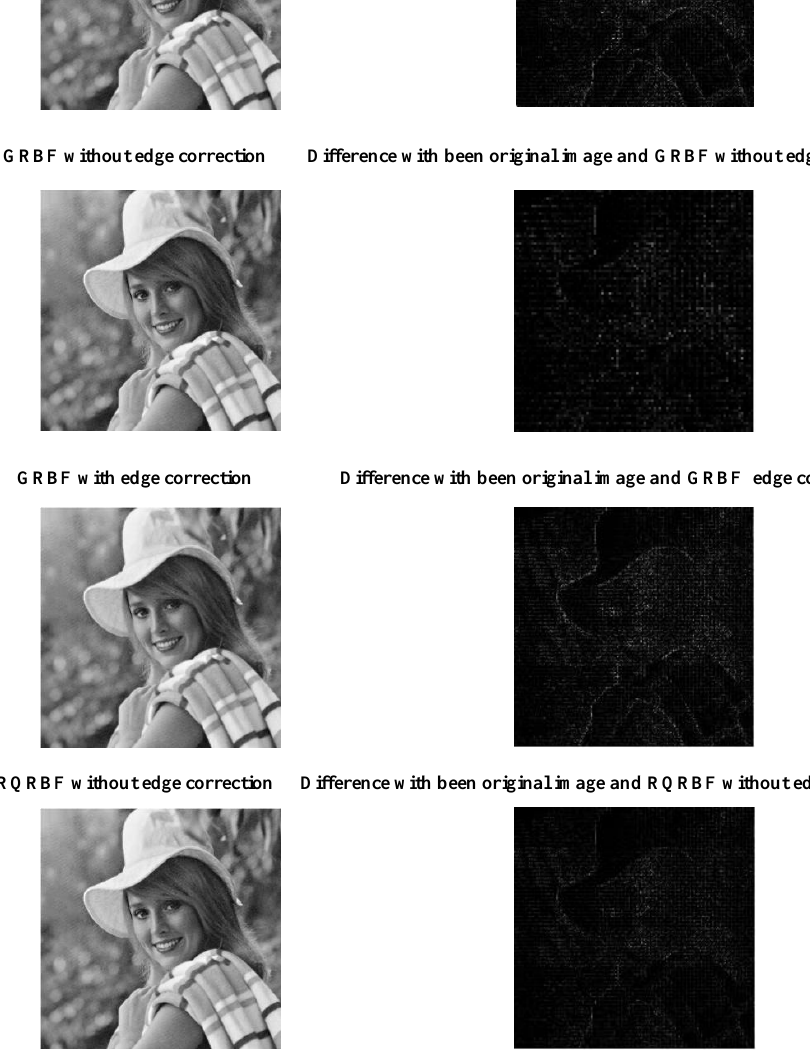
Figure 8. Results of Elaine’s image zooming by factor of 2 and using different